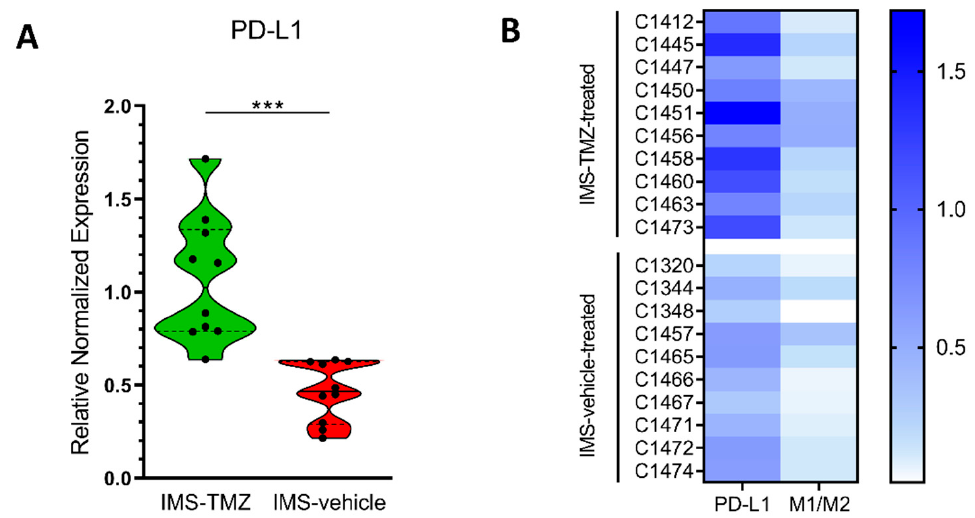
Figure 4. ( A ) Violin plot for comparisons of PD-L1 level analysis expression in tumour samples from IMS-TMZ-treated GL261 GB and control mice ( p < 0.0001). Data are the mean ± SD and significant differences between groups are indicated by asterisks (*** p < 0.001). Explanations for violin plots as in Figure 2. ( B ) Visual coloured map for normalised expression representing PD-L1 expression level (from Figure 4A) and M1/M2 ratio (from Figure 3C) in each individual case. Pearson correlation analysis in the whole group showed overall significance ( p = 0.013), although when pairs of values were analysed separately for control and IMS-TMZ-treated groups, only the control set of values showed significance ( p = 0.048), which was lost for values from treated